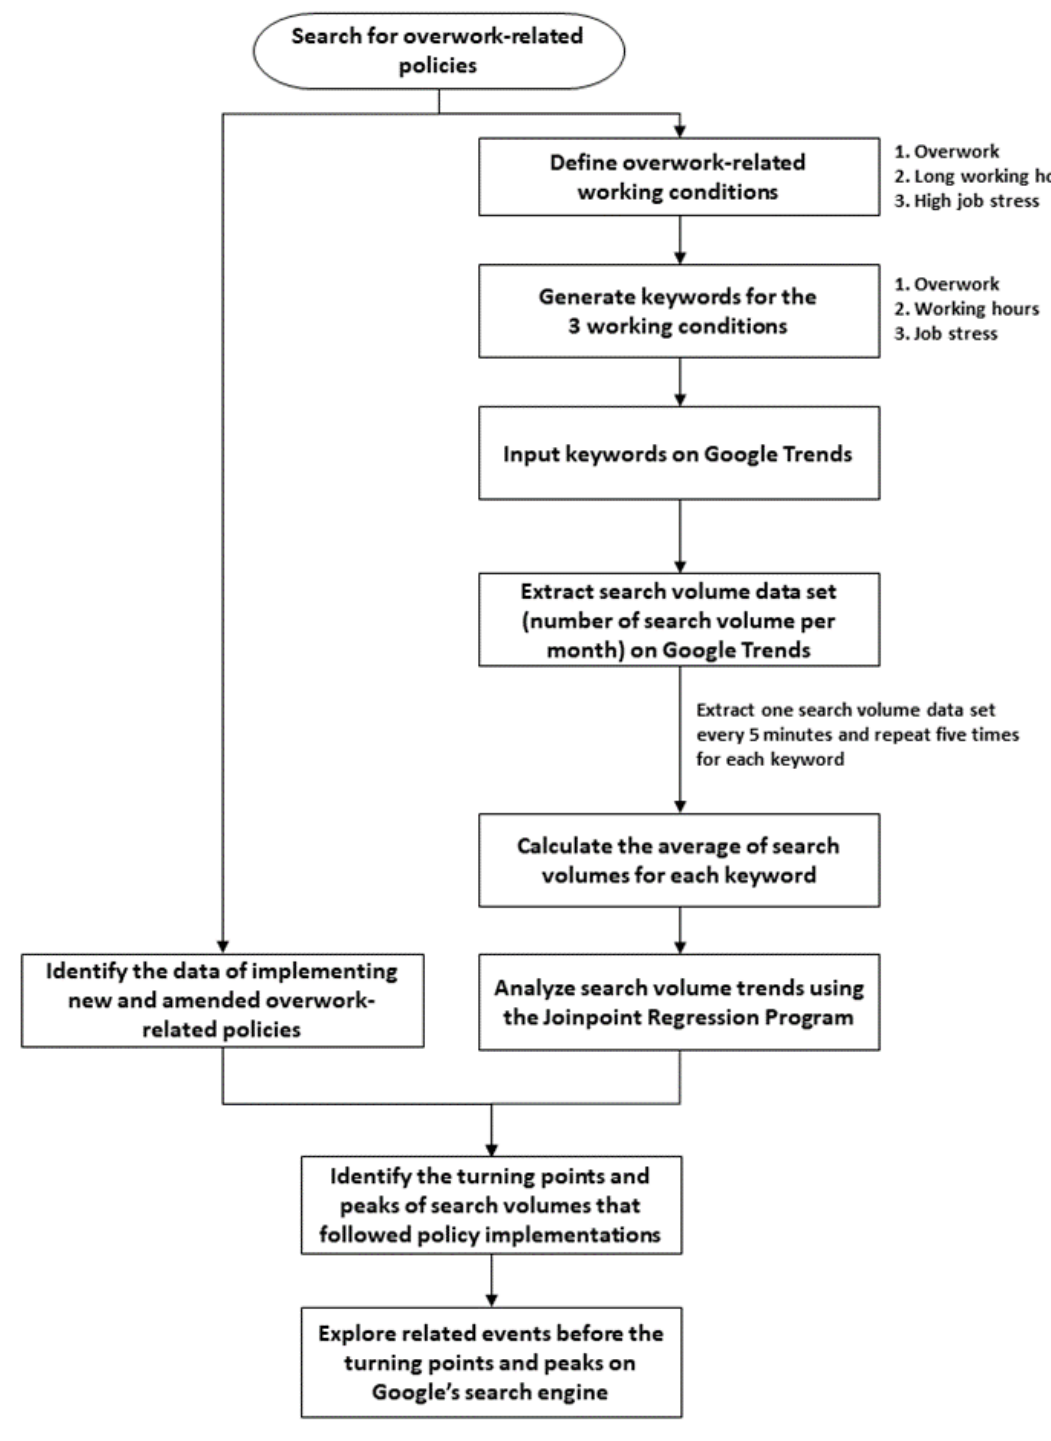
Figure 1. The study